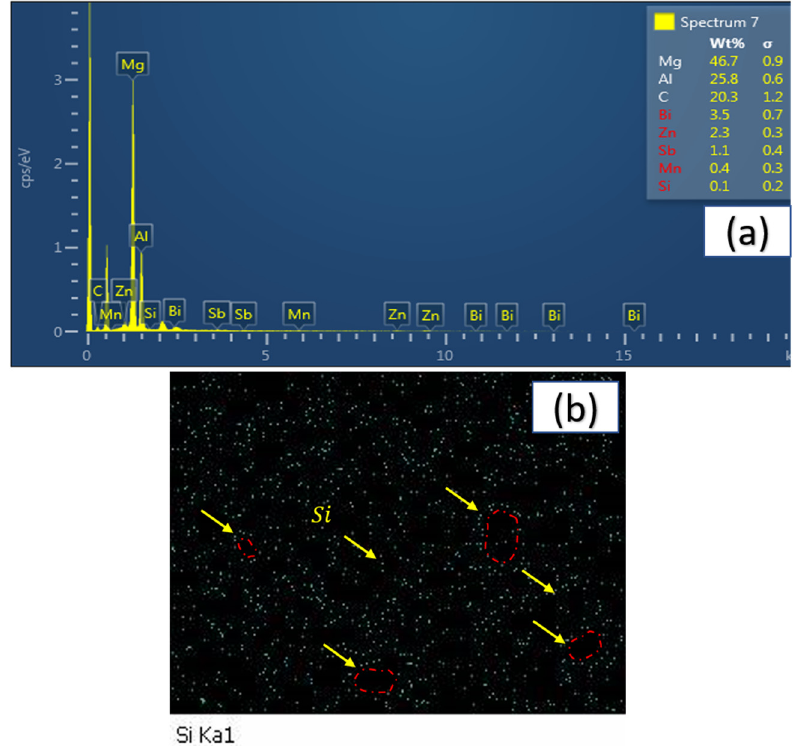
Figure 11. EDS spectra of ( a ) AZ91 + 0.5 wt.% SiCp + 1 wt.% Bi + 0.4 wt.% Sb and ( b ) Si particle dispersion at the boundary region of AZ91 + 0.5 wt.%